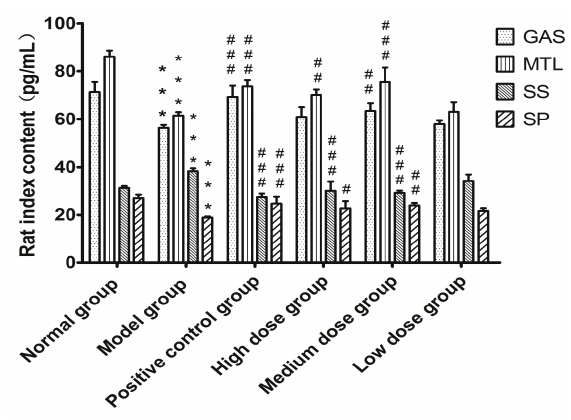
Fig. 3 The body weight of rats for 24 h